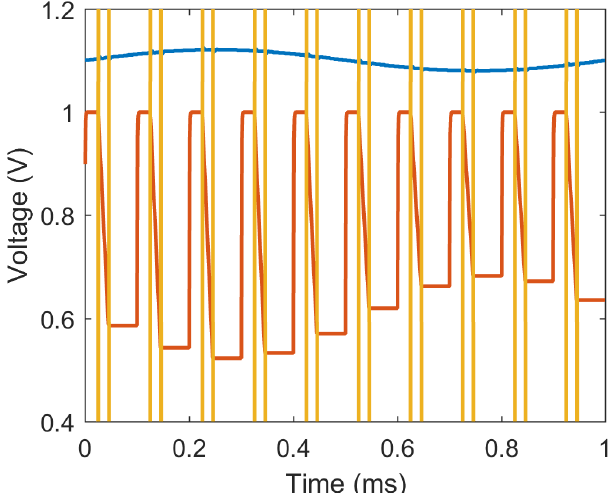
Figure 4. Simulation results of the PPG readout circuit. (Blue) Output of the transimpedance amplifier. (Orange) Output of the switched integrator. (Yellow) Control signal for switch S1, which is also used for the LED